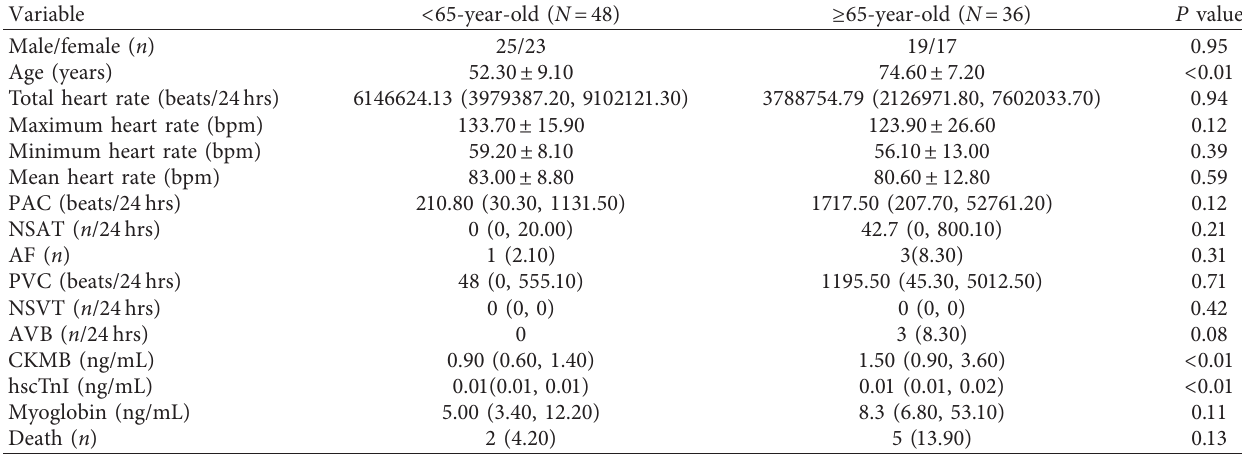
Table 5: Arrhythmias, cardiomyocyte injury markers, and death between < 65-year-old and ≥ 65-year-old patients with COVID-19.